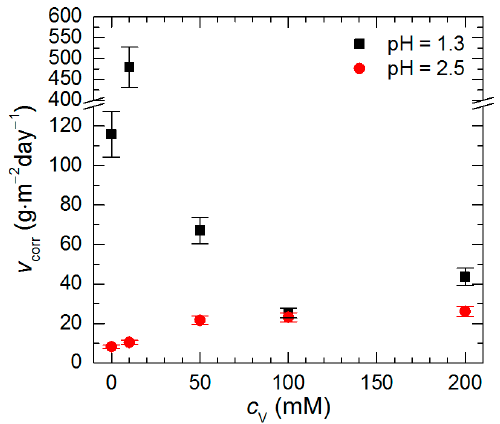
Figure 5. Corrosion rate of intermetallic Al 2 Cu in H 2 SO 4 solutions after t = 576 min at T = 303 K as a function of pH and initial concentration of Na 3 VO 4.